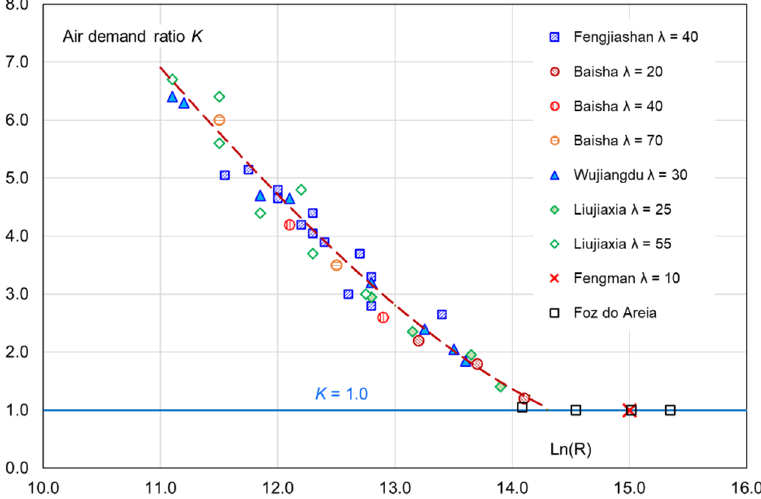
Figure 9. Reynolds number ‐ based comparisons of aerator air flows between prototypes and models. Six chute spillway aerators are included (based on the data in [12,22]).